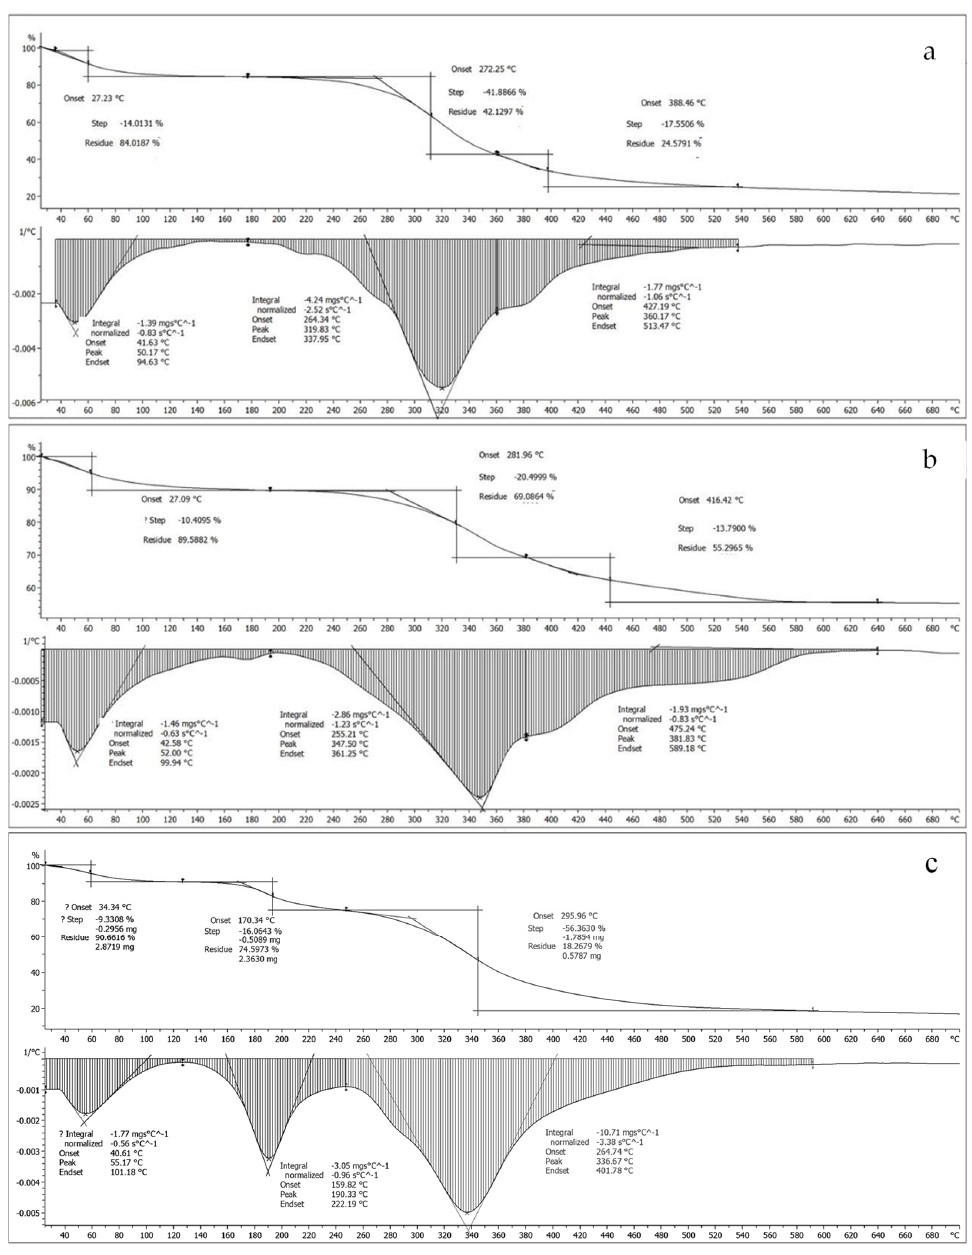
Figure 7. TGA graphs of extracts from ( a ) the skin and ( b ) the bone, and ( c ) type I